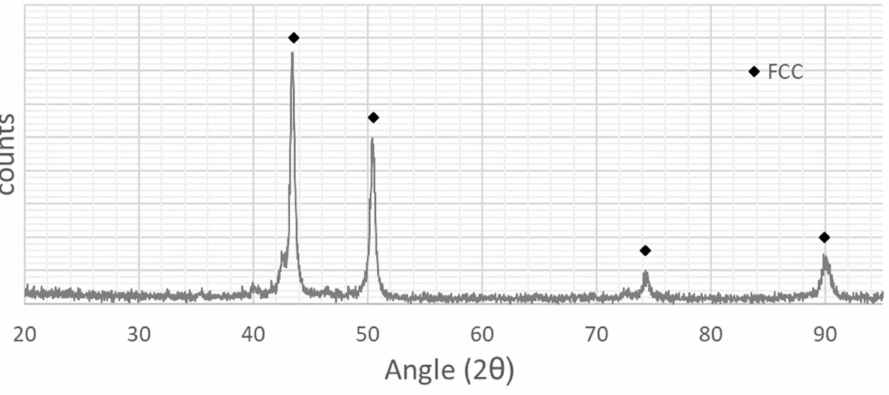
Figure 10. XRD Data.